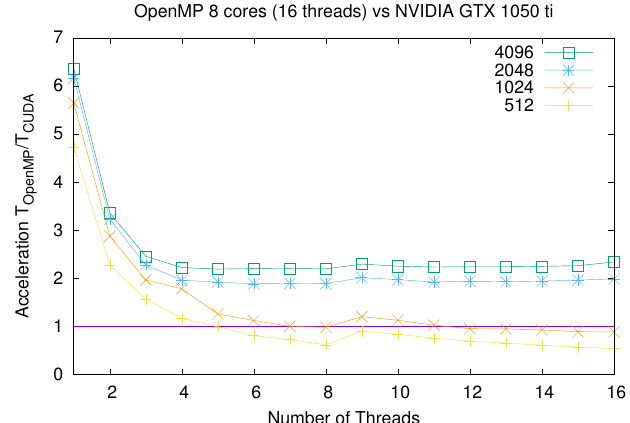
Figure 5. Comparison of OpenMP Optimized and CUDA times when using Intel Core i9 and NVIDIA GeForce GTX 1050 Ti resp.